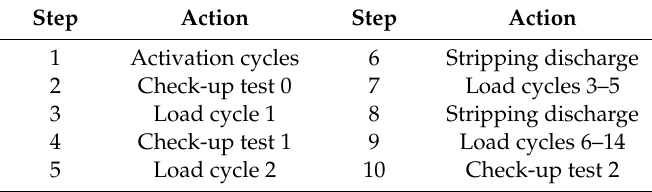
Table 3. Test plan with ten sequential steps applied in this test series for all test points.